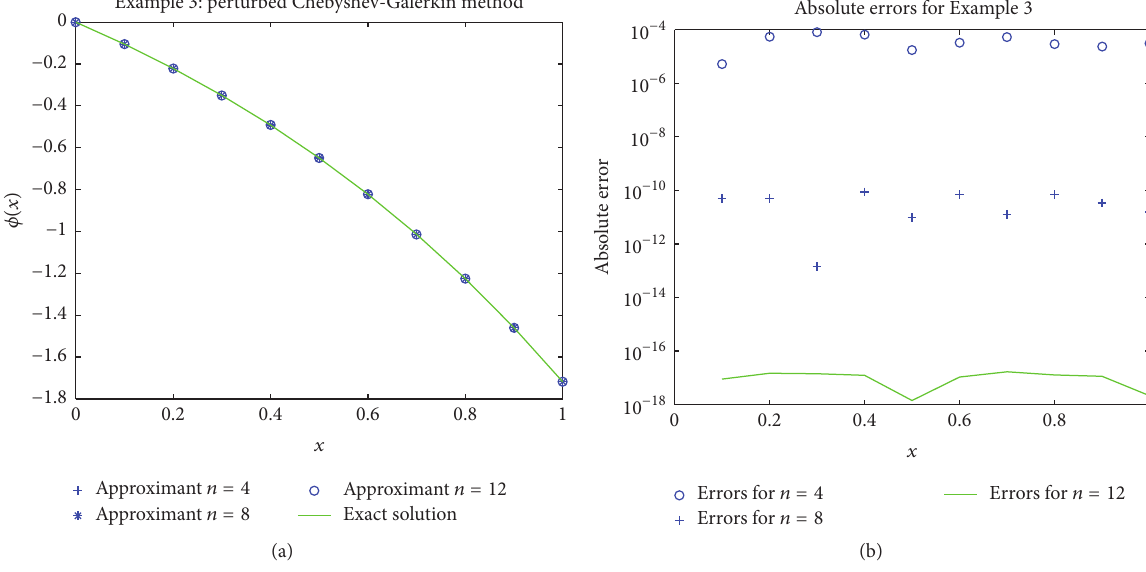
Figure 3: The approximate solution for Example 3 and its absolute errors for different 𝑛 .